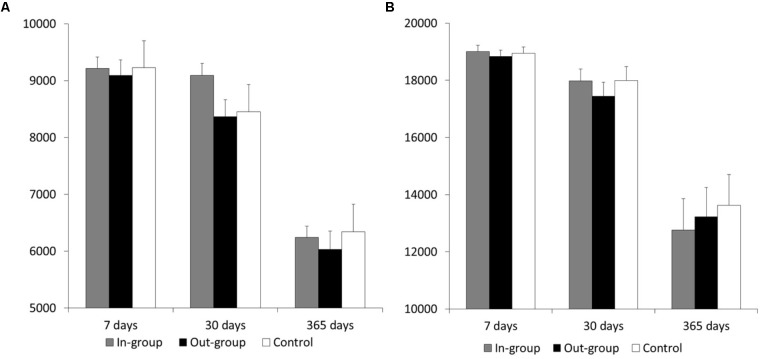
Participants’ indifference points in each condition and each delay period when (A) the delayed money was 10,000 yen, and (B) the delayed money was 20,000 yen. The error bars indicate SE.